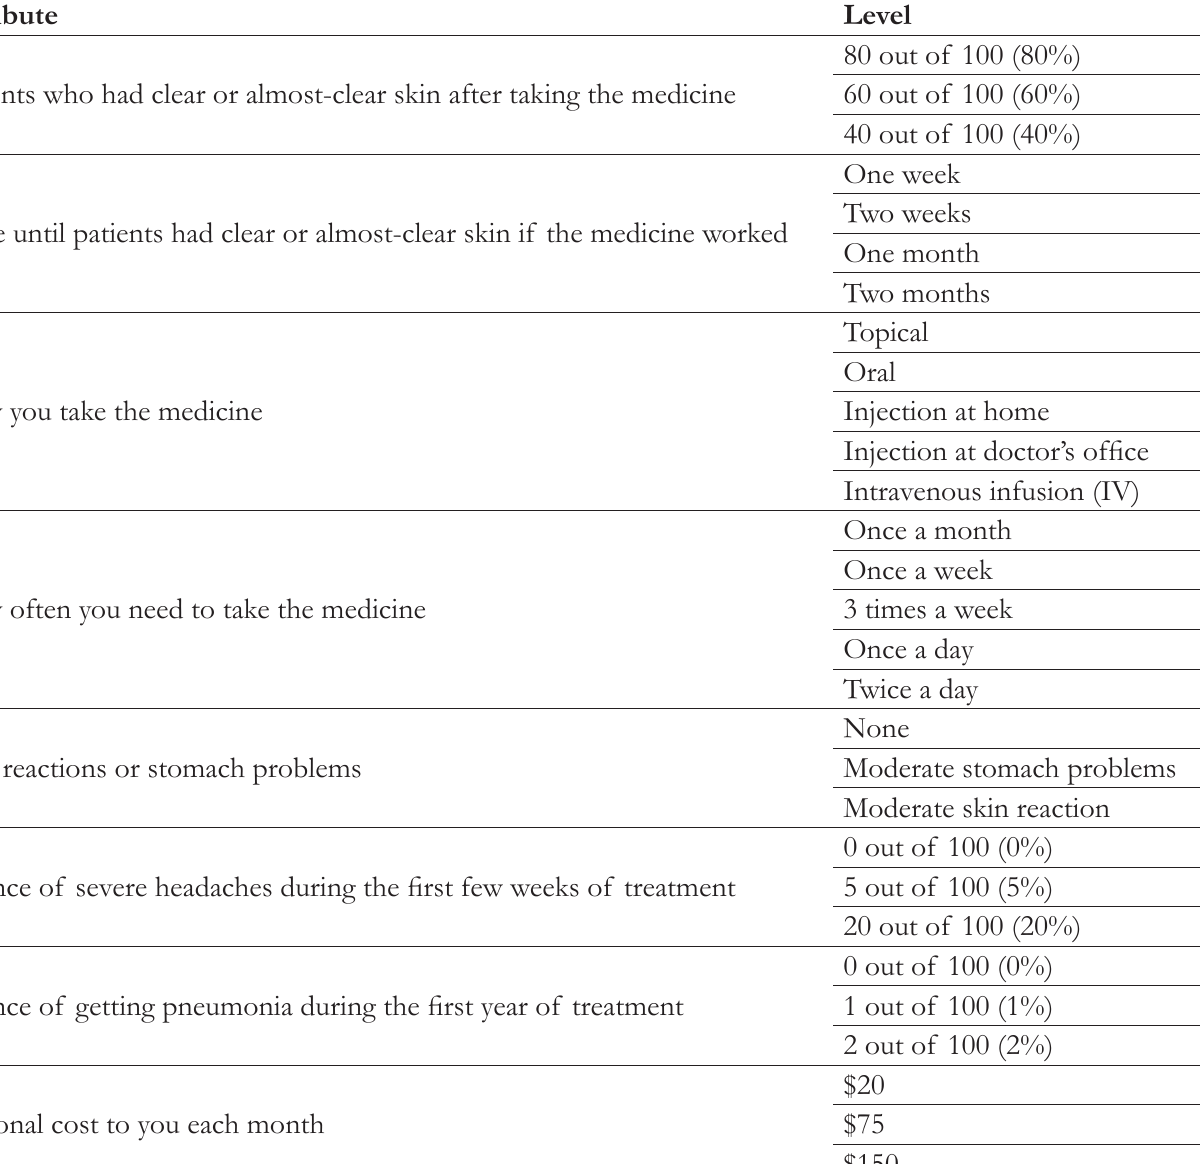
Table 1. Attributes and Levels Included in the Survey